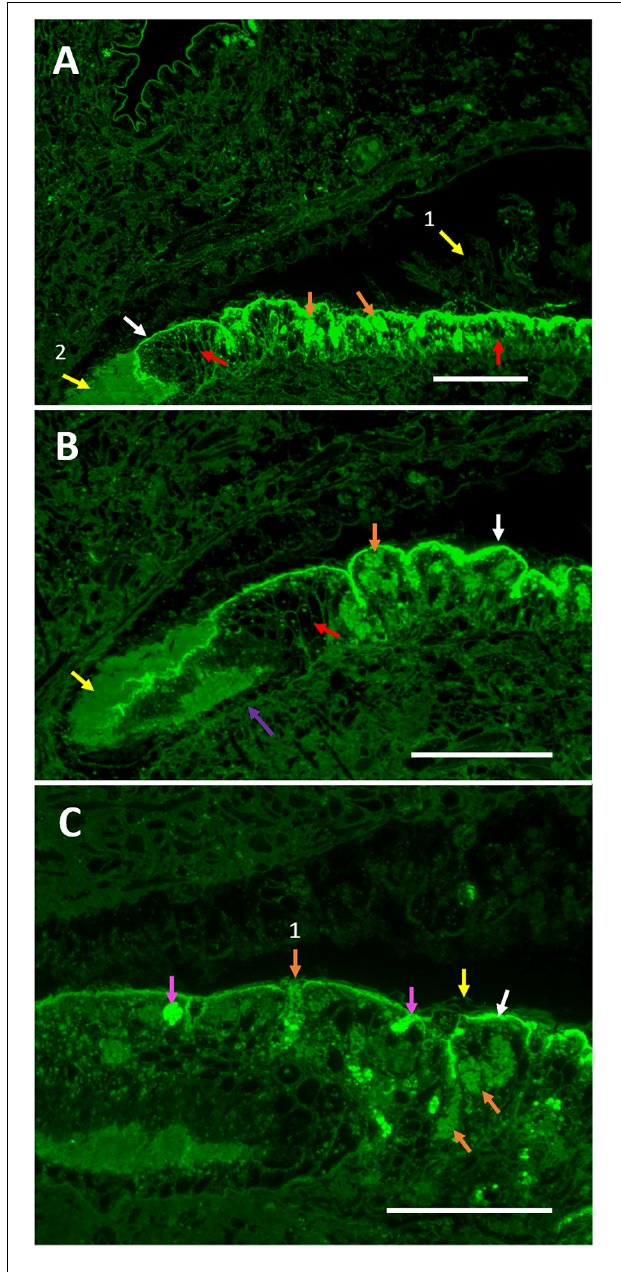
FIGURE 7 | Folian immuno-reactivity in the periostracal groove region between the outer and middle mantle lobes. (A) Intensely staining folian-positive material localizes along the surface of the outer lobe epithelium (white arrow) along with but separate from a different material presumed to be periostracal material (yellow arrow 1). It is presumed that the material at the very base of the groove is periostracal material that collected there and is moved distally to the shell edge during shell formation (yellow arrow 2). Numerous folian-positive secretory cells (orange arrows) are visible and interspersed with non-staining cells which appear black (red arrows). Scale bar 140 µ m. (B) Increased magnification shows the groove appears to be lined with simple cuboidal cells (purple arrow) adjacent to the non-staining secretory cells evident on the distal end of the groove (red arrow). At this lower saturation, folian-positive granules are visible (orange arrow) within cells.